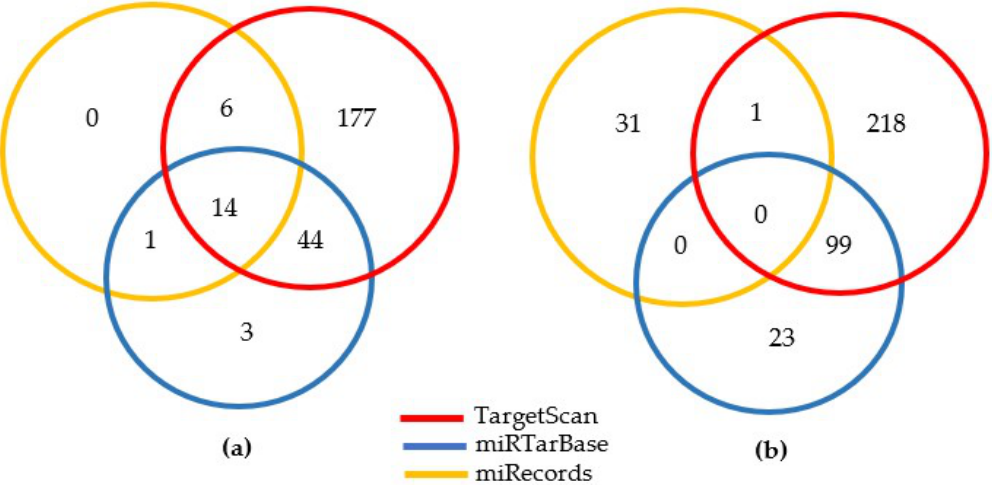
Figure 2. The distribution of cardiometabolic genes ( a ) and cardiometabolic disease-associated miRNAs ( b ) by database (access date: 1 June 2017). ( a ) We extracted 304 cardiometabolic genes from published GWAS, of which 245 are predicted targets for miRNAs; ( b ) A total of 372